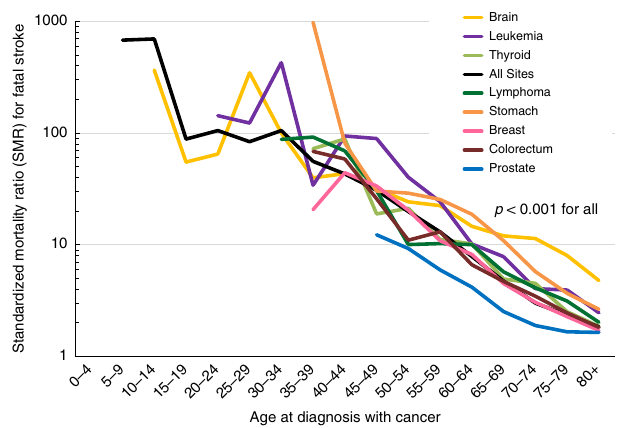
Fig. 2 Standardized mortality ratios (SMRs) of fatal stroke as a function of age of diagnosis. The y -axis depicts the SMR, and the x -axis depicts the age at diagnosis with cancer. SMRs compare the risk of death from stroke among a cancer subsite vs the general population, adjusted sex and race, within a particular age subgroup. Cancers are shown in different colors; for the purposes of this fi gure, key cancers were selected because of their high incidence and prevalence overall (e.g., prostate, breast, colorectum) and because of their relatively high incidence in pediatric populations (e.g.,